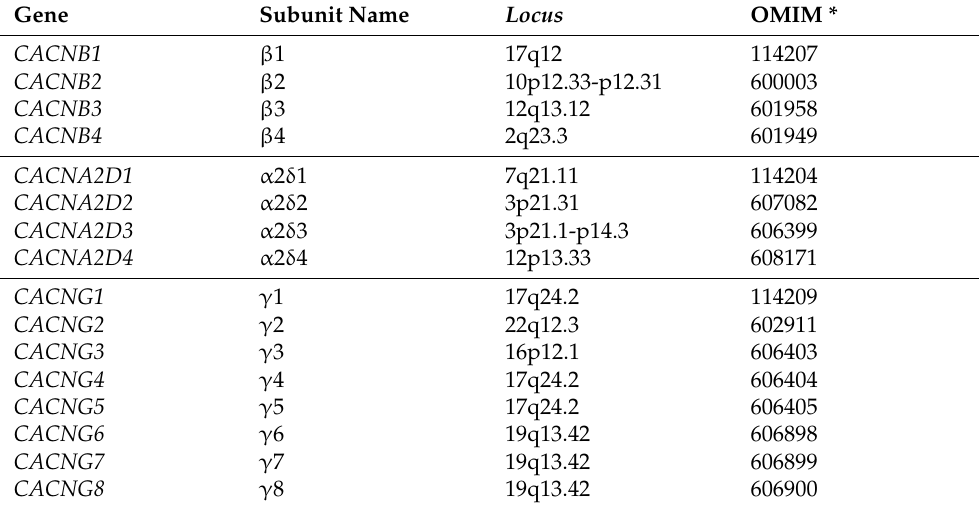
Table 3. Genes coding for the different auxiliary subunits of the voltage-gated Ca 2+ channels ( β , α 2 δ , and γ